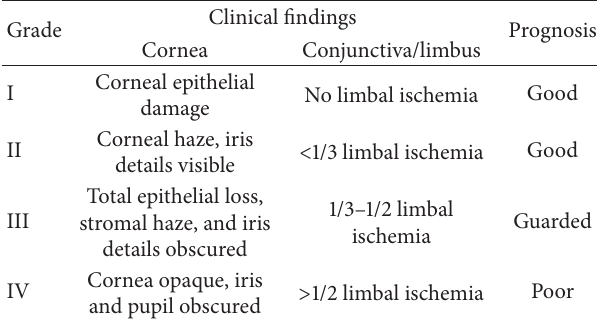
Table 1: Roper-Hall classification for the severity of ocular surface